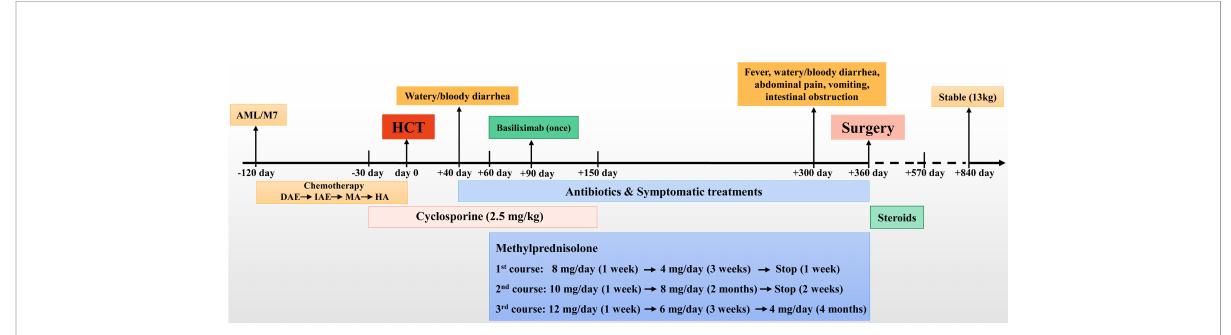
FIGURE 1 The timeline of the treatments. AML, acute myeloid leukemia; HCT, hematopoietic cell